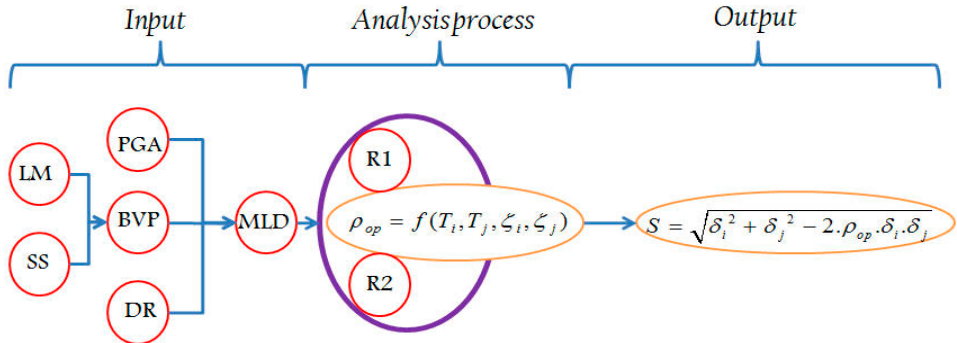
Figure 1. Schematic architecture of the CRVK program model.